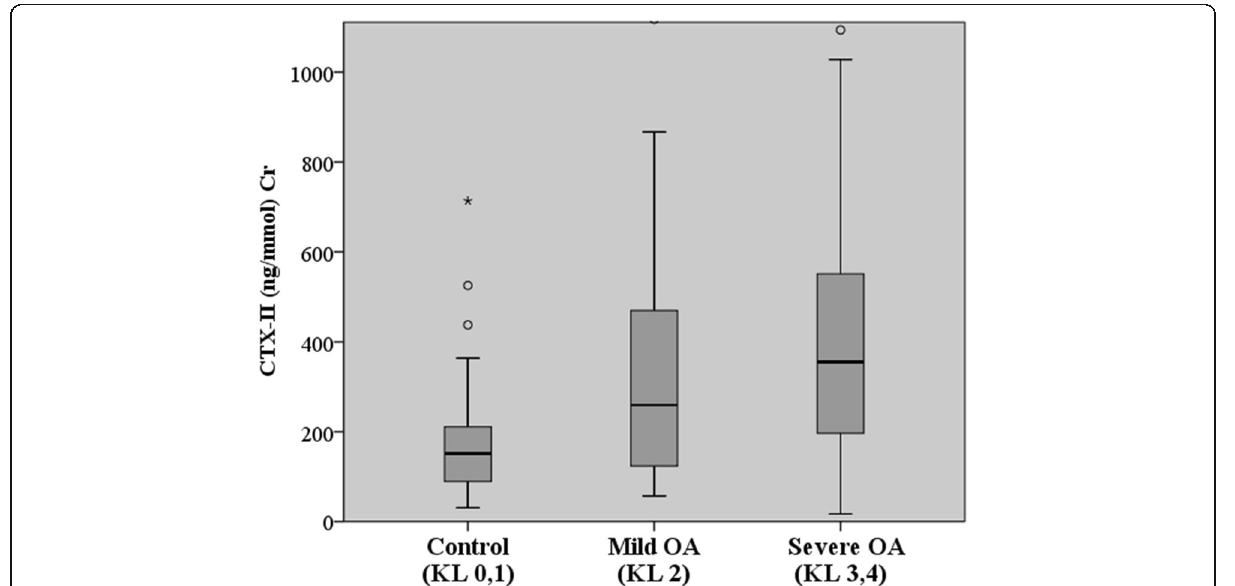
Fig. 2 Comparison of the levels of urinary CTX-II in different radiographic knee